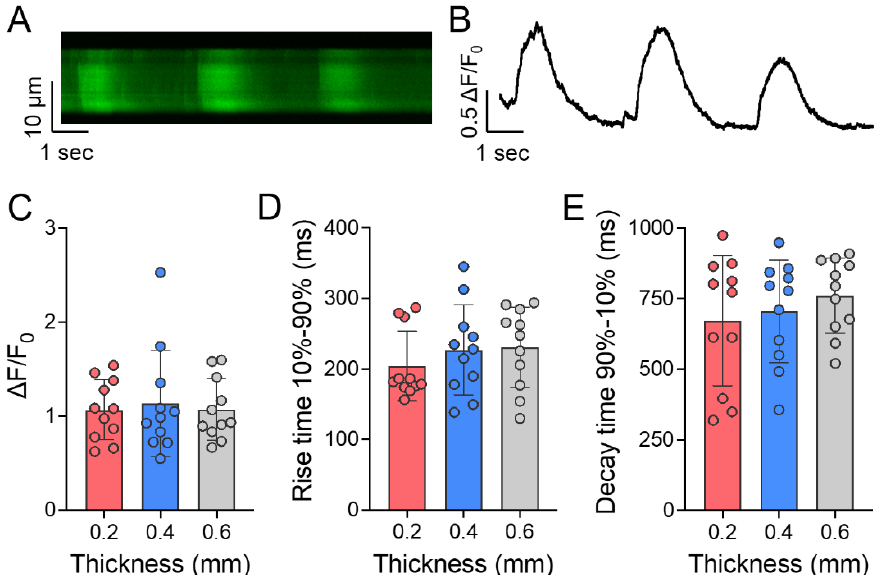
Figure 7. Calcium transients of day 7 high density iPSC-CM laden auxetic patches with three thicknesses. ( A ) Representative line scan from spontaneously beating iPSC-CMs in the patch; ( B ) Corresponding fluorescence trace; ( C ) Calcium transient amplitudes, ( D ) rise times, and ( E ) decay times for 0.2, 0.4, and 0.6 mm thickness patches. Mean ± SD.